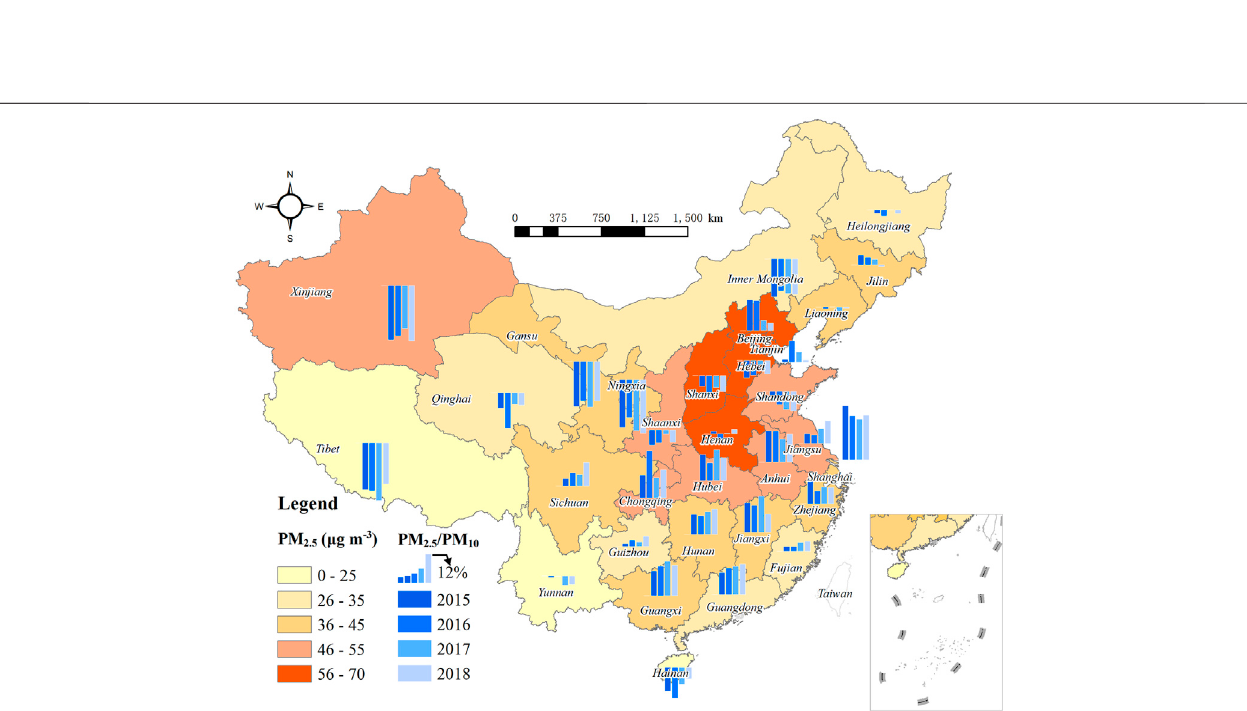
Frontiers in Environmental Science |